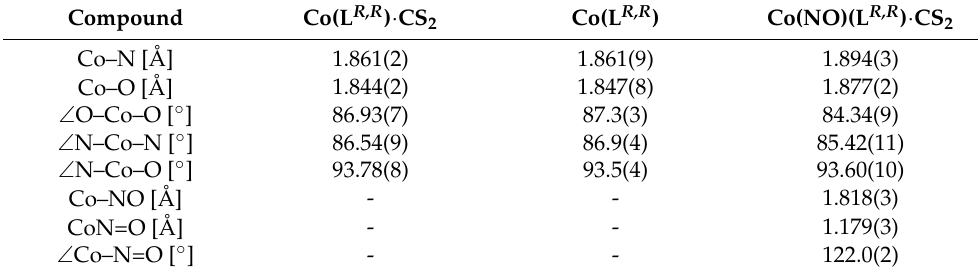
Table 2. Selected mean bond distances and